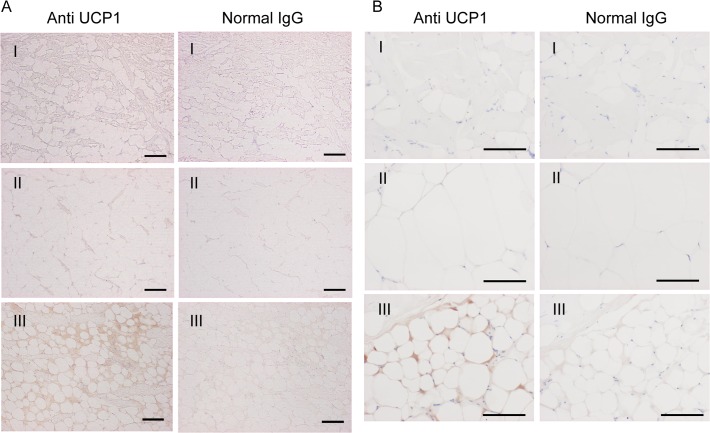
Immunohistochemical analysis of dolphin blubber.Sections of blubber from (A) Pacific white-side dolphin (SNH11012) and (B) bottlenose dolphin (UMUT-12343), immunoreacted with anti-UCP1 antibody or normal IgG. Outer (I), middle (II) and inner (III) layer. Scale bar = 100 μm.